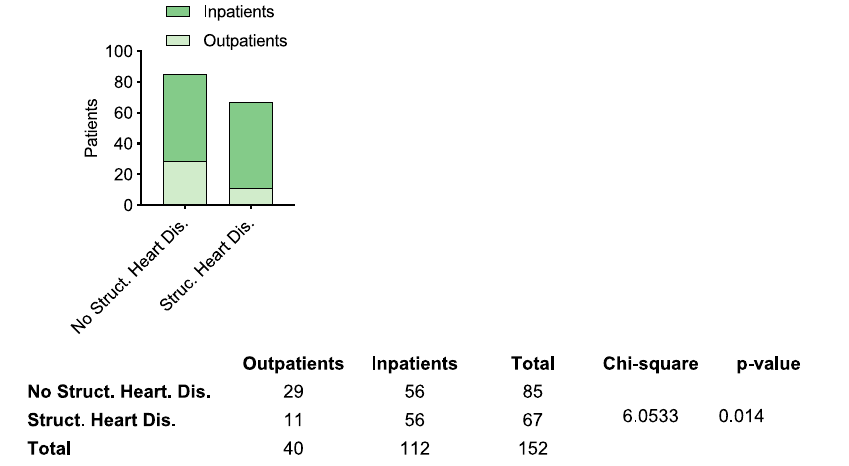
Fig. 1 Relationship between structural heart disease and hospitalization rates upon SARS-CoV-2 infection. A signi fi cant relationship between pathological echo fi ndings and hospitalization rate in 152 patients who tested positive for SARS-CoV-2 could be found ( p < 0.0002,